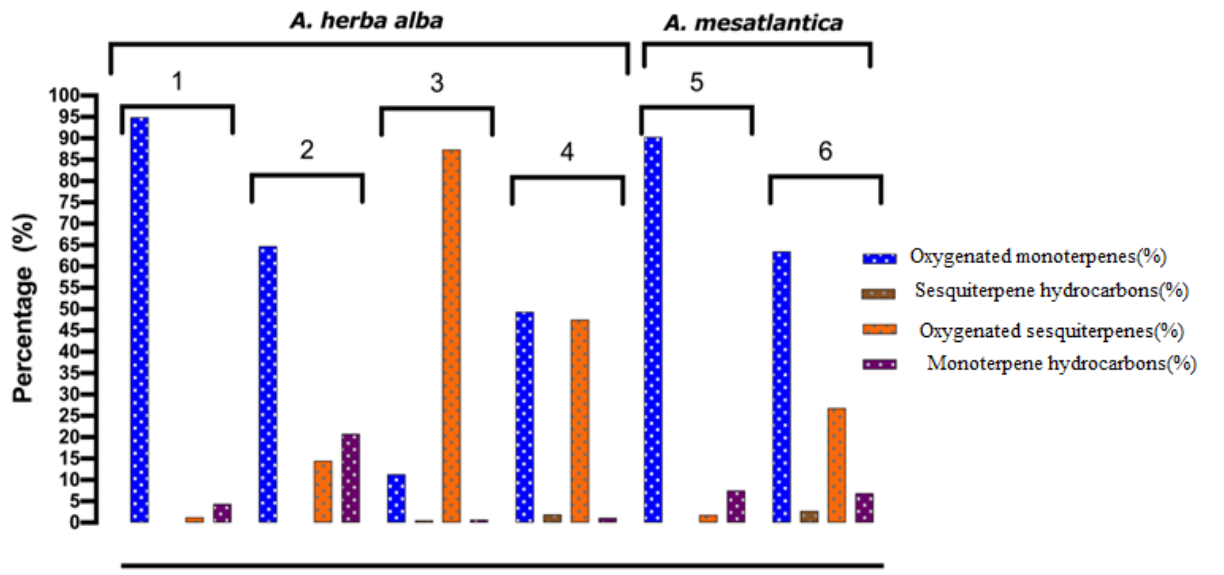
Figure 3. Different classes of compounds identified in the EOs of A. herba alba Asso: ( 1 ) Lime- stone/Semi-arid; ( 2 ) Poor loamy and stony soil/Semi-arid; ( 3 ) Limestone/Semi-arid, arid; ( 4 ) Lime- stone/Subhumid to humid, A. mesatlantica ; ( 5 ) Rocky soil on limestone/Subhumid to humid; ( 6 ) Limestone/Subhumid to humid.